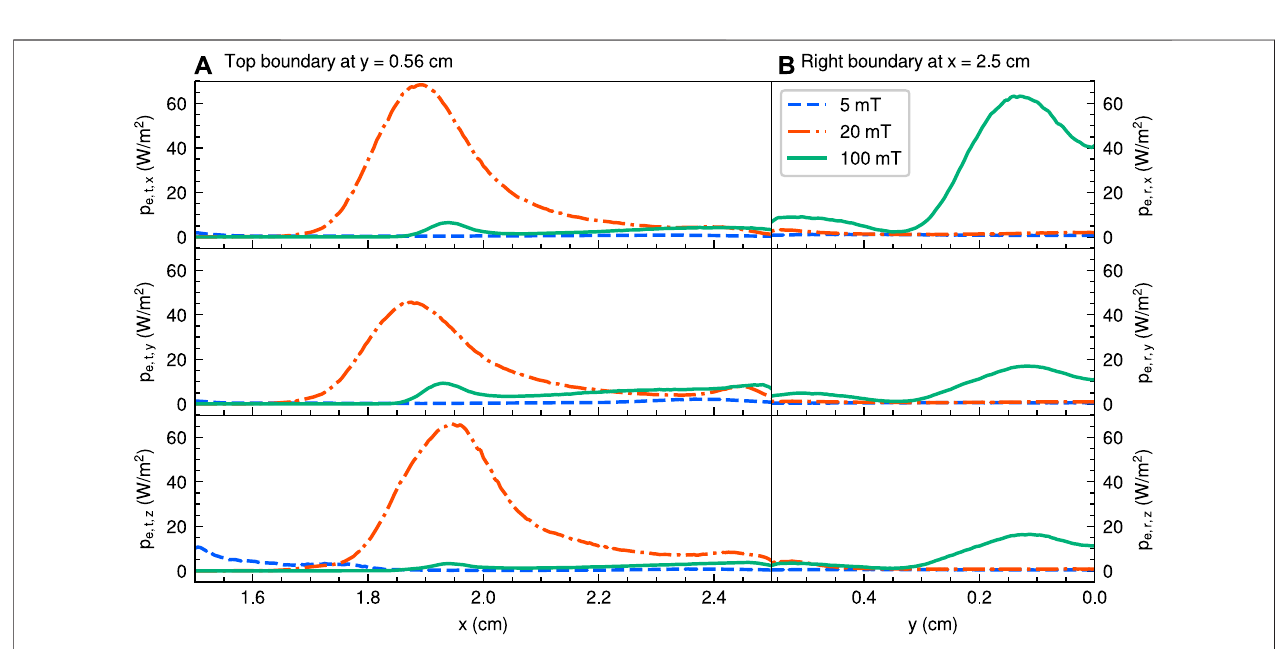
FIGURE10|(A) x pro fi lesoftheelectronenergy fl uxesonthetopboundary( y (cid:1) 0.56 cm) p e , t , x , p e , t , y ,and p e , t , z and (B) y pro fi lesoftheelectronenergy fl uxesonthe right boundary ( x (cid:1) 2.5 cm) p e , r , x , p e , r , y , and p e , r , z , for the three magnetic fi eld strengths of 5 (a dashed blue line), 20 (a dotted-dashed orange line), and 100 mT (a solid green line). Note that x (cid:1) 2.5 cm in (A) corresponds to y (cid:1) 0.56 cm in (B) .